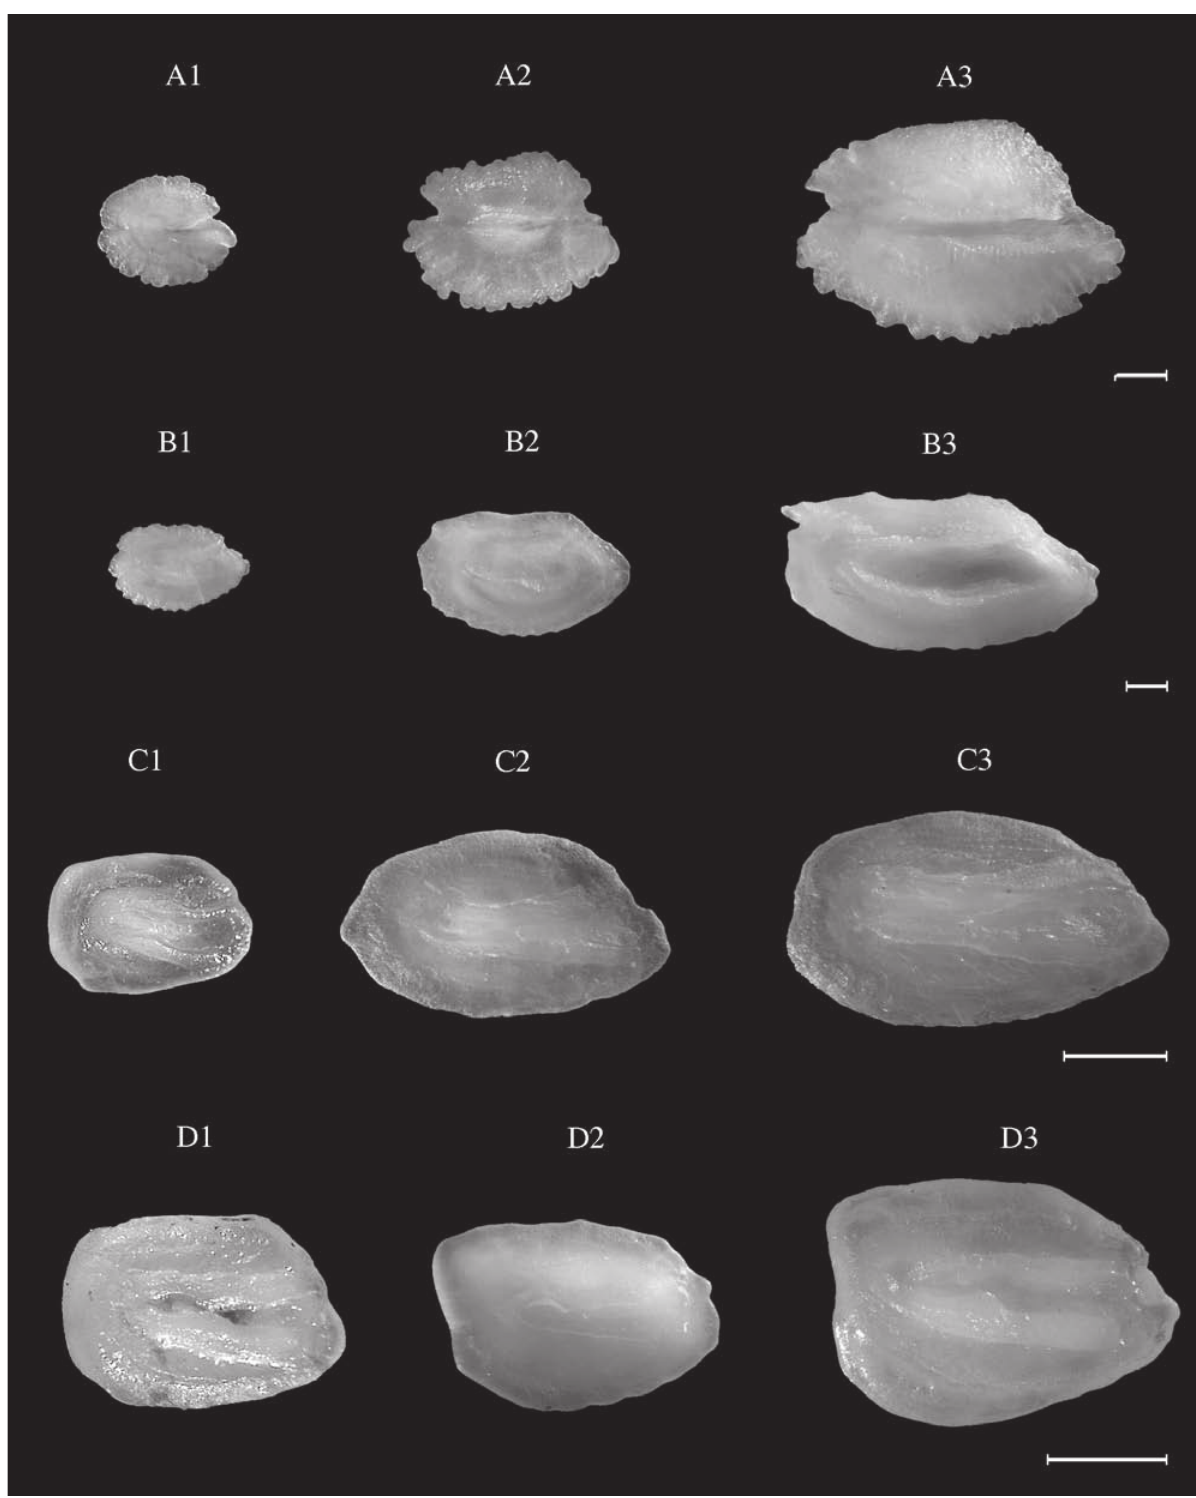
Fig. 89. – Scophthalmus rhombus. TL: A1, 14.8 cm (NEA); A2, 20.0 cm (WM); A3, 35.2 cm (NEA). Platichthys flesus (NEA). TL: B1, 14.5 cm; B2, 26.7 cm; B3, 34.6 cm. Arnoglossus imperialis . TL: C1, 10.5 cm (WM); C2, 14.3 cm (NEA); C3, 18.8 cm (NEA). Arnoglossus laterna. TL: D1, 11.0 cm (WM); D2, 11.0 cm (NEA); D3, 14.4 cm (NEA). Scale bar = 1